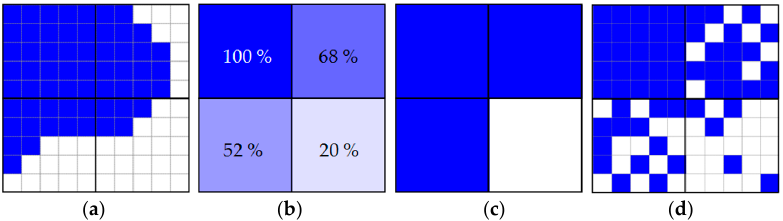
Figure 3. ( a ) Reference high resolution map, ( b ) semi-simulated fractions with ZF = 5, ( c ) hard classified map, and ( d ) a possible random sub-pixel map.